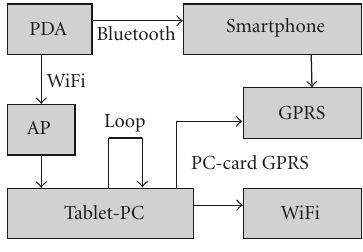
Figure 2: Portable unit modules interconnection.